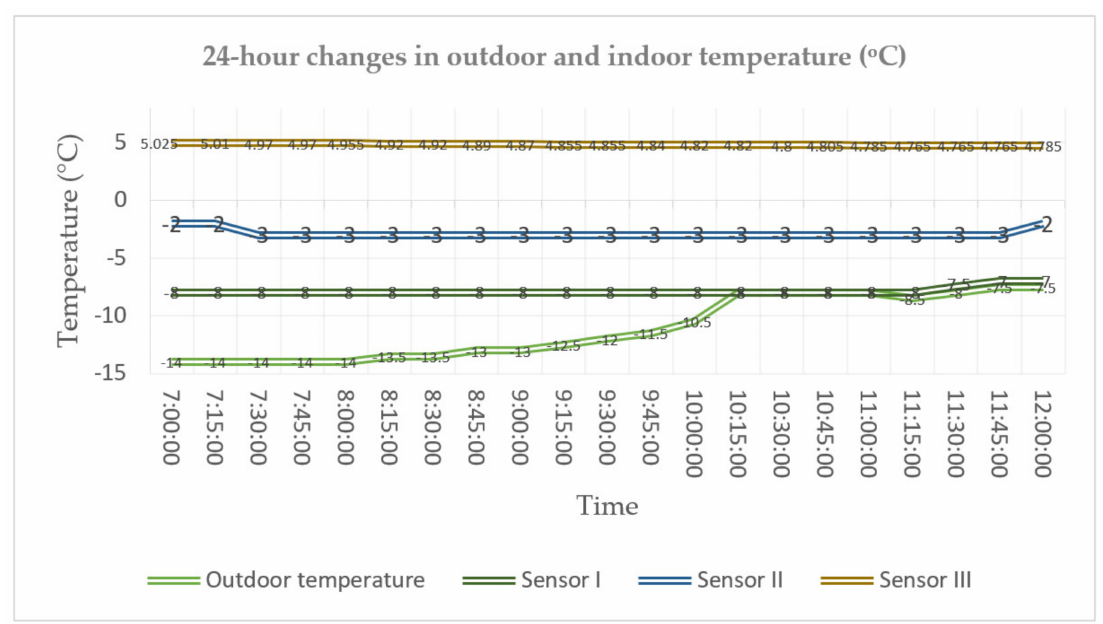
Figure 10. The 24-h distribution of outdoor temperature and temperature inside the building